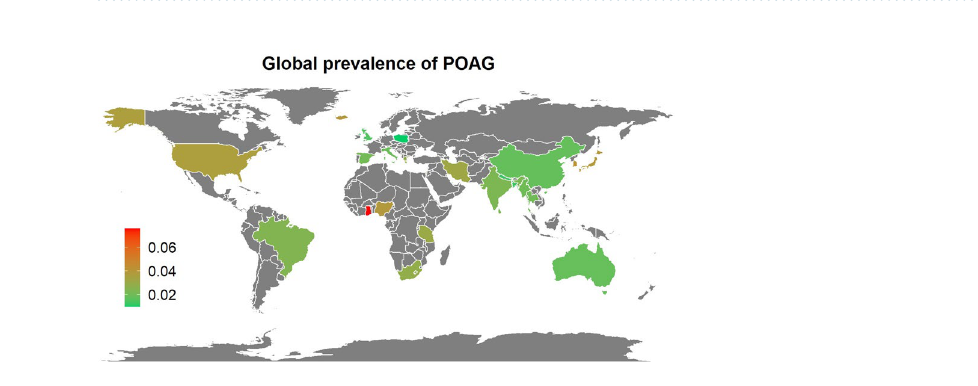
Figure 5. Global prevalence of primary open-angle glaucoma. This world map was created using R (version 3.6.3) and R package “ggplot2”. The country codes (ISO3) used in the program were downloaded from www. natio nsonl ine. org.